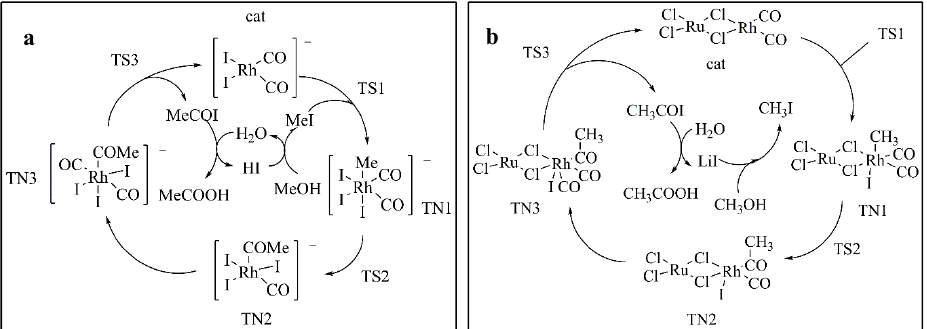
Figure 3. Diagram of the reaction mechanism for methanol carbonylation: ( a ) cycle for Monsanto catalyst catalyzed carbonylation of methanol to acetic acid; ( b ) cycle for Rh(I)/Ru(III) bimetallic catalyst catalyzed carbonylation of methanol to acetic acid.